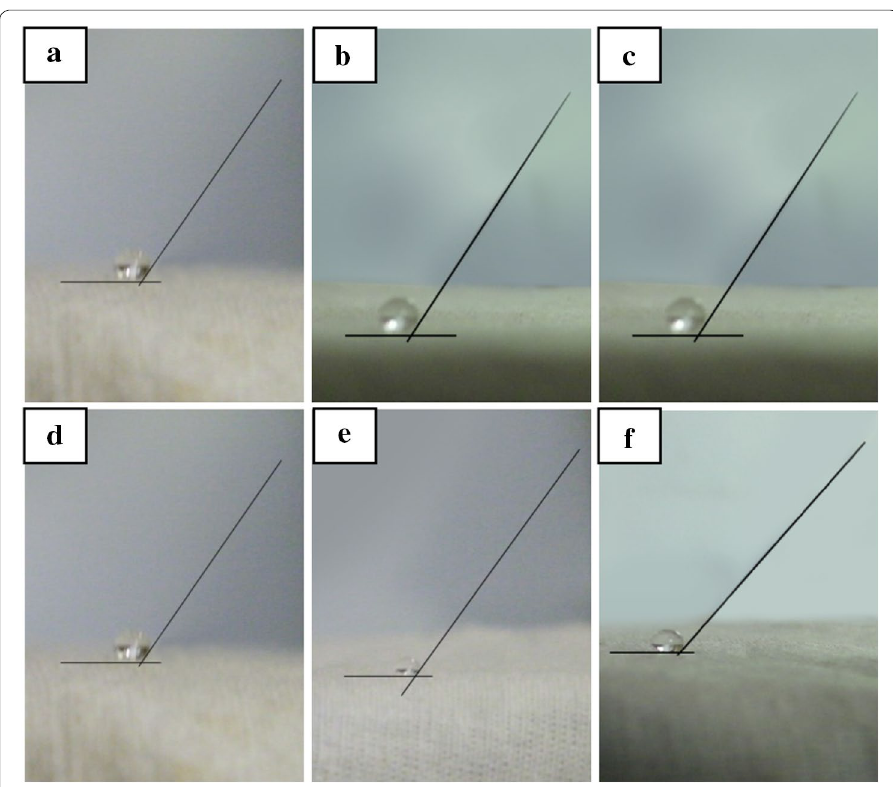
Fig. 1 WCA of treated cotton with fluorocarbon at 20 g/L, 40 g/L and 60 g/L before and after 10 washes. a 20 g/L—unwashed-WCA (123°); b 40 g/L—unwashed-WCA (123°); c 60 g/L—unwashed-WCA (127°); d 20 g/L—10 washes-WCA (125°); e 40 g/L—10 washes-WCA (126°); f 60 g/L—10 washes-WCA